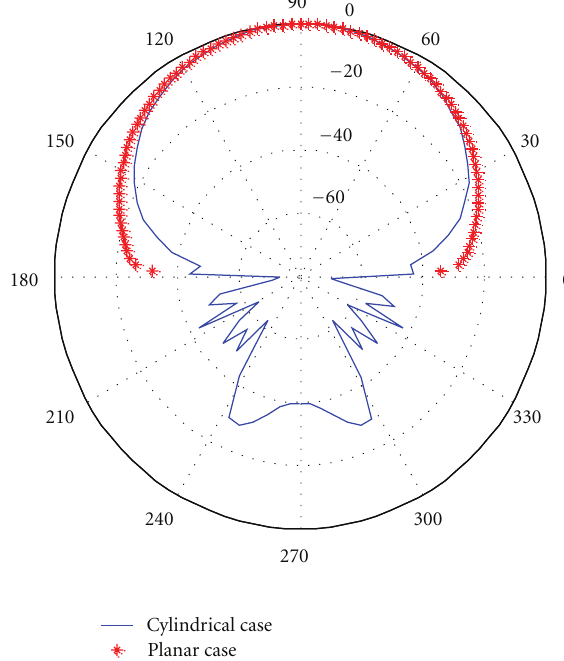
Figure 12: Normalised radiation field in xoz -plane (dB).